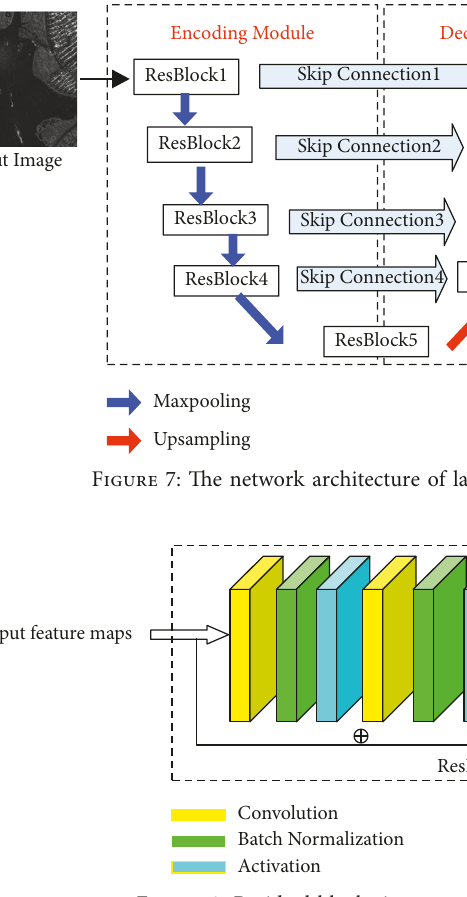
Figure 8: Residual blocks in segmentation